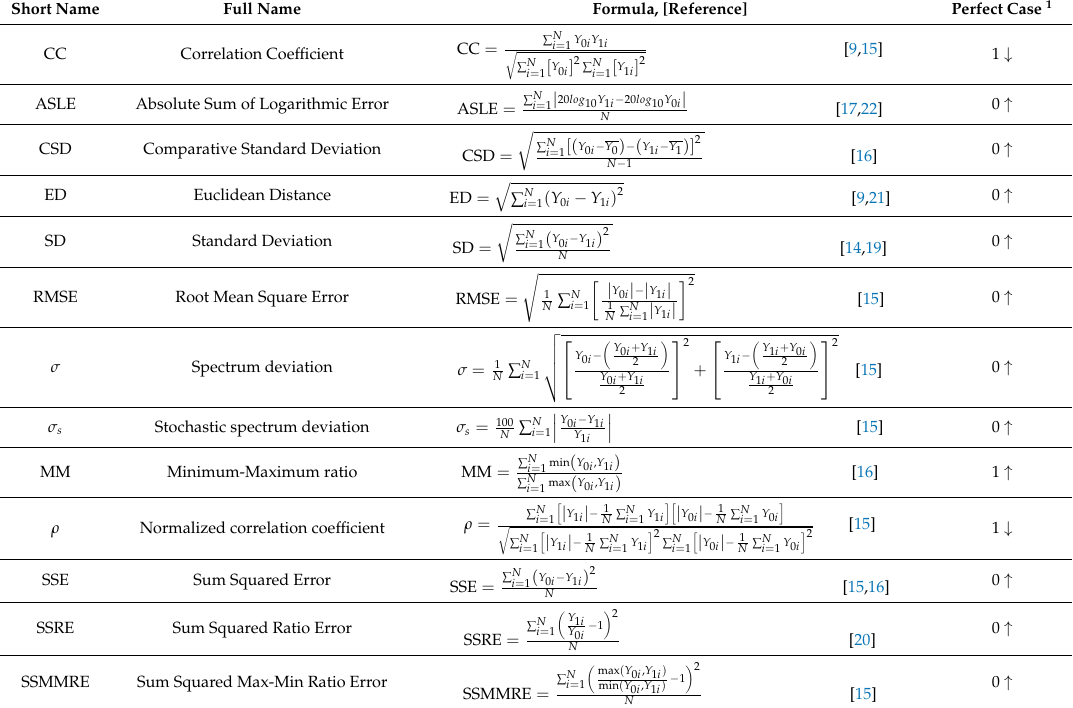
Table 1. Numerical indices used for assessment of test data